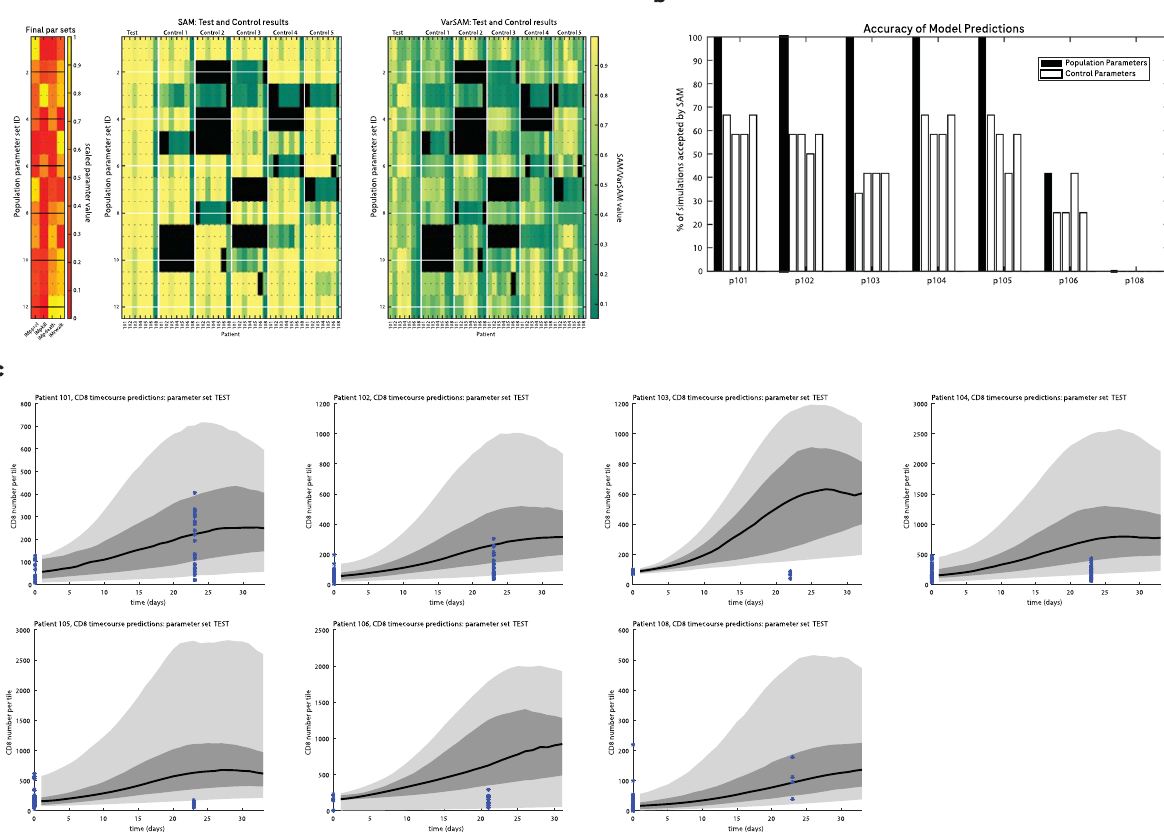
Fig. 5 Model validation. a Heatmaps showing the SAM and VarSAM of the population parameters applied to the test dataset of seven patients. The fi rst seven columns of the middle and right heatmaps correspond to the simulations using the population parameters and the rest of the columns correspond to simulations using fi ve independent control sets of randomly selected parameter values for comparison. Colours are as in Fig. 4a. b Summary bar plot of the heatmaps in fi gure ( a ). Parameter sets were considered accepted if the SAM had a value of >0.7 and the VarSAM had a value of >0.3. c Simulated timecourses of the numbers of CD8 cells using the test parameters with 50% (dark grey) and 90% (light grey) quantiles for each of the patients in the test group. The blue * indicates the actual number of CD8 cells per tile in baseline and on-treatment samples from each